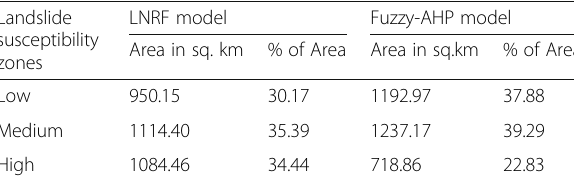
Table 6 Areal distributions of LSM based on LNRF and Fuzzy- AHP